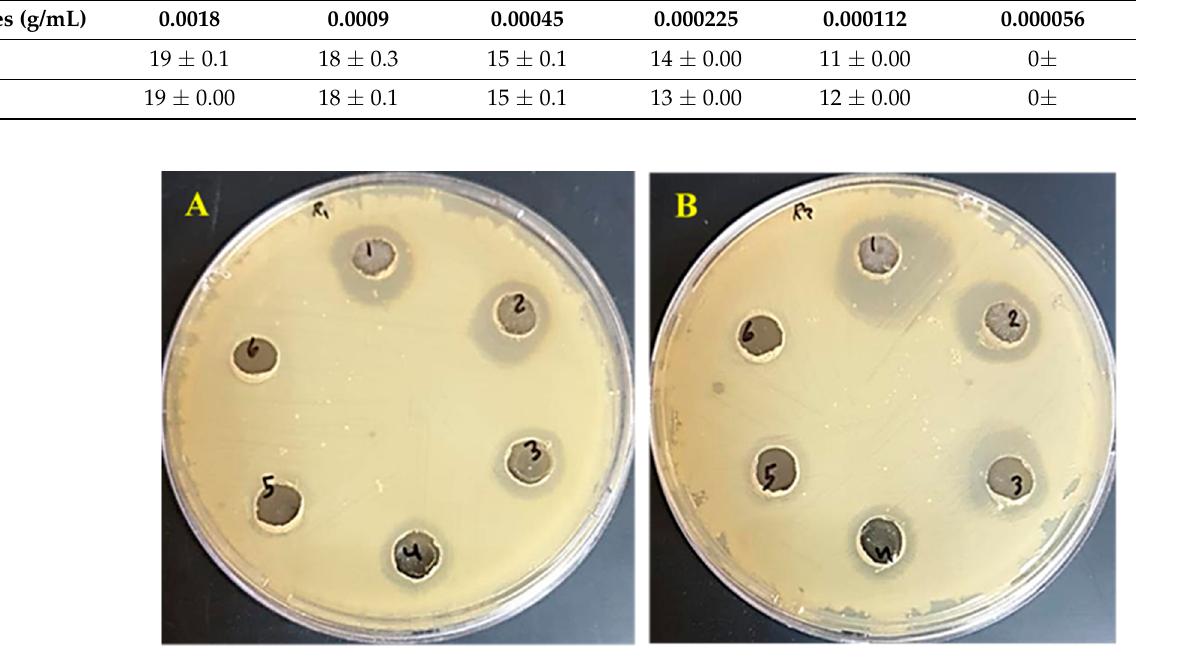
Figure 10. Effect of different concentrations (mg/mL) of Ulva /Ag/cellulose nanocomposites on S. mutans ( A ) and L. acidophilus ( B ). Table 5. Inhibition zone (mm) of S. mutans ATCC 25175 and L. acidophilus CH-2 at different con-